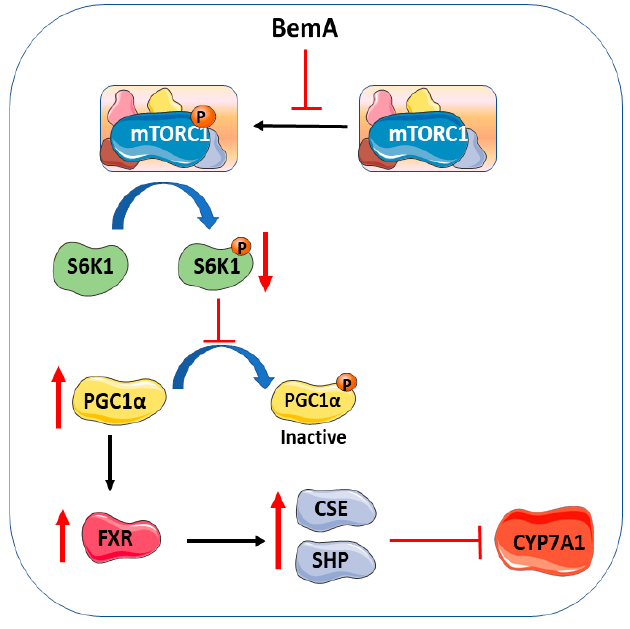
Figure 9. BemA’s effect on the mTORC1/S6K1/PGC1 α pathway.